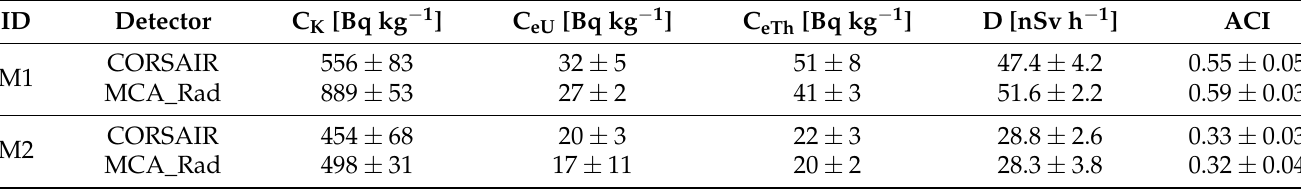
Table 3. Comparison between the specific activities, effective doses and ACI estimated by the CORSAIR equipment during the M1 and M2 measurements and the corresponding laboratory analyses performed by the MCA_Rad